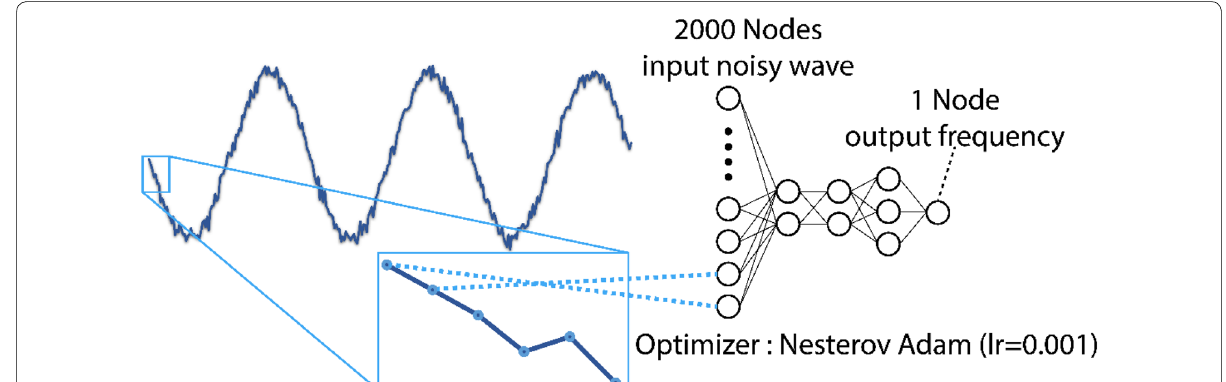
Fig. 1 Schematic of the neural network (NN) model. To prepare the noisy sine wave as the input of the NN model we took 2000 samples from each wave. Each data sample is a node in the input layer of the NN model as is shown here. The NN model has three hidden layers with 2, 2, and 3 neurons in the first, second and third, respectively. The output layer has only one node, which represents the desired frequency. The Nesterov Adam optimizer with a learning rate (lr) of 0.001 was used for this